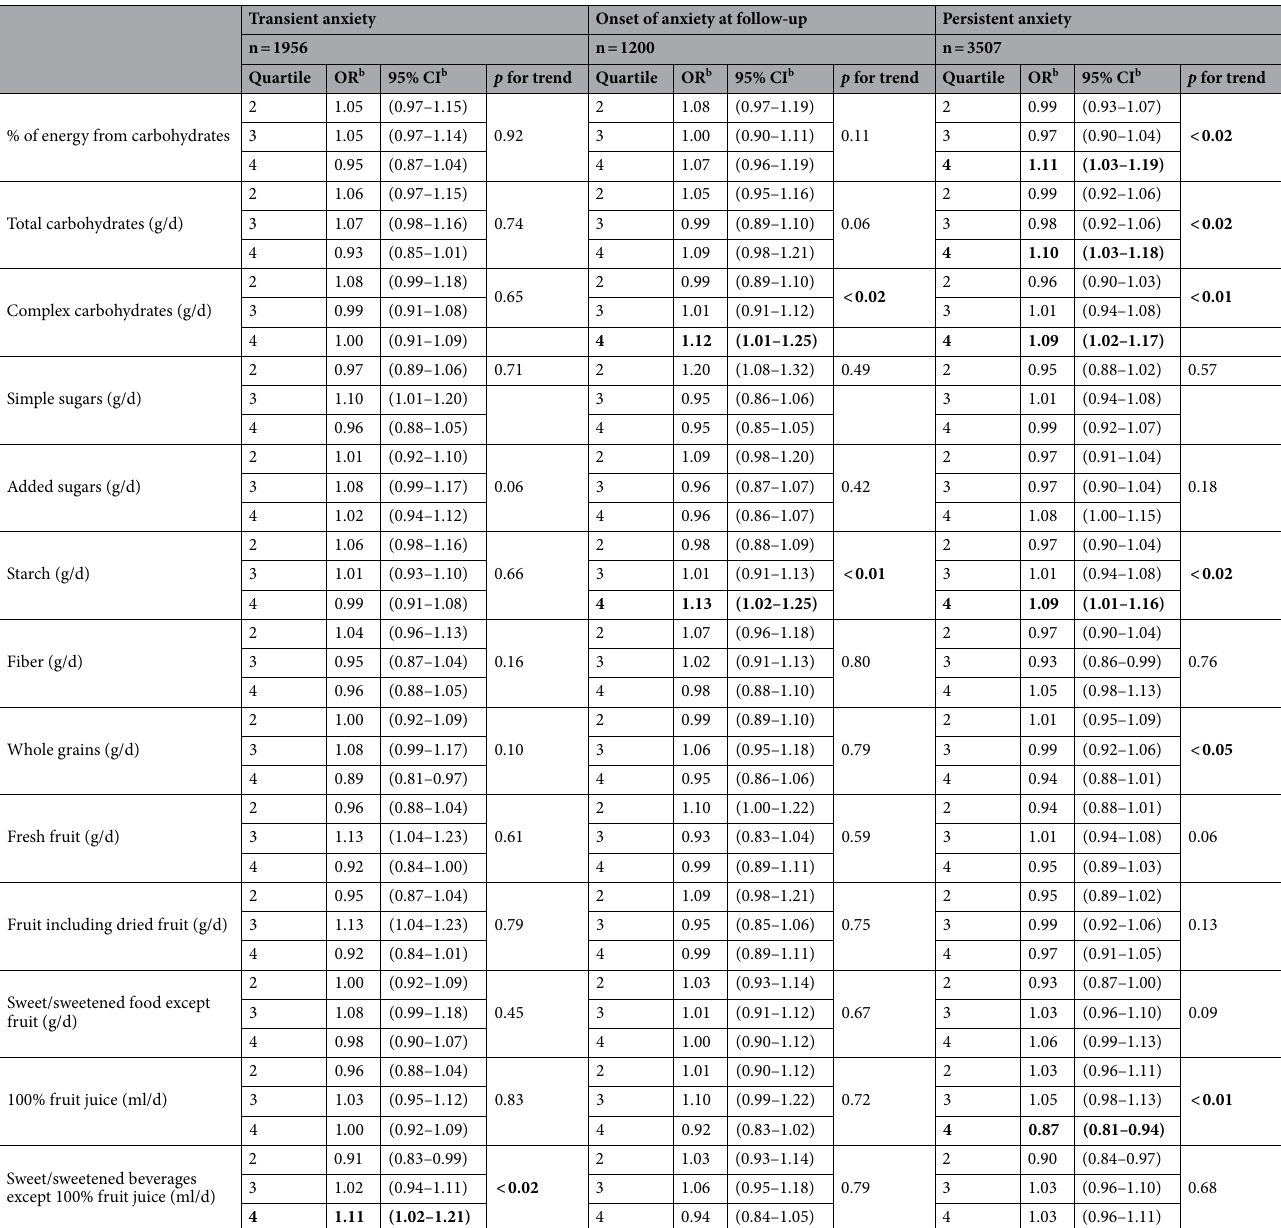
Table 3. Associations between quartiles of carbohydrate intake and anxiety status a (N = 15,602; NutriNet- Santé cohort; France). a Anxiety status assessed with the trait subscale of Spielberger’s State-Trait Anxiety Inventory form Y (STAI-T). STAI-T score > 40 points considered as high general anxiety; anxiety categories as follows: (1) None = no reported high general anxiety at any time point; (2) Transient anxiety = high general anxiety reported only at baseline; (3) Onset of anxiety at follow-up = high general anxiety reported only at follow-up; (4) Persistent anxiety = high general anxiety reported at baseline and follow-up. b Results from multivariable polytomous logistic regression (reference categories: anxiety status = None (n = 8939) and lowest quartile of carbohydrate intake) adjusted for age (time-scale), BMI (continuous variable), sex, number of 24-h dietary records, smoking status, educational level, employment status, physical activity level, sedentariness, alcohol intake, marital status, and presence of children aged < 18 y in household. Values are rounded off to two decimal places. Significant results are shown in